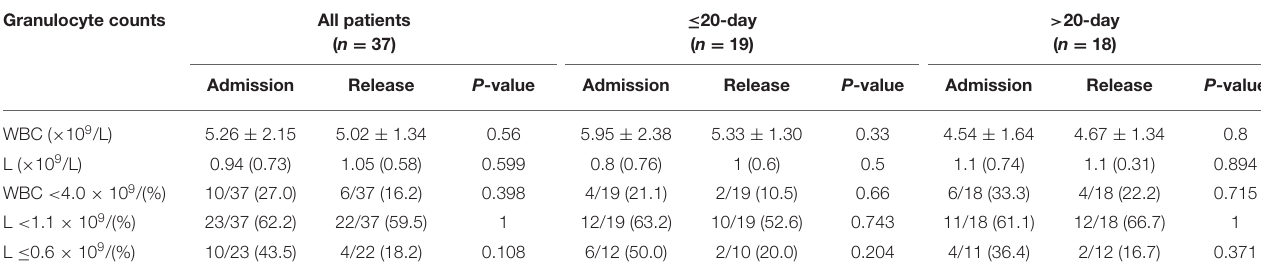
TABLE 4 | Granulocyte counts on admission and release from quarantine. Granulocyte